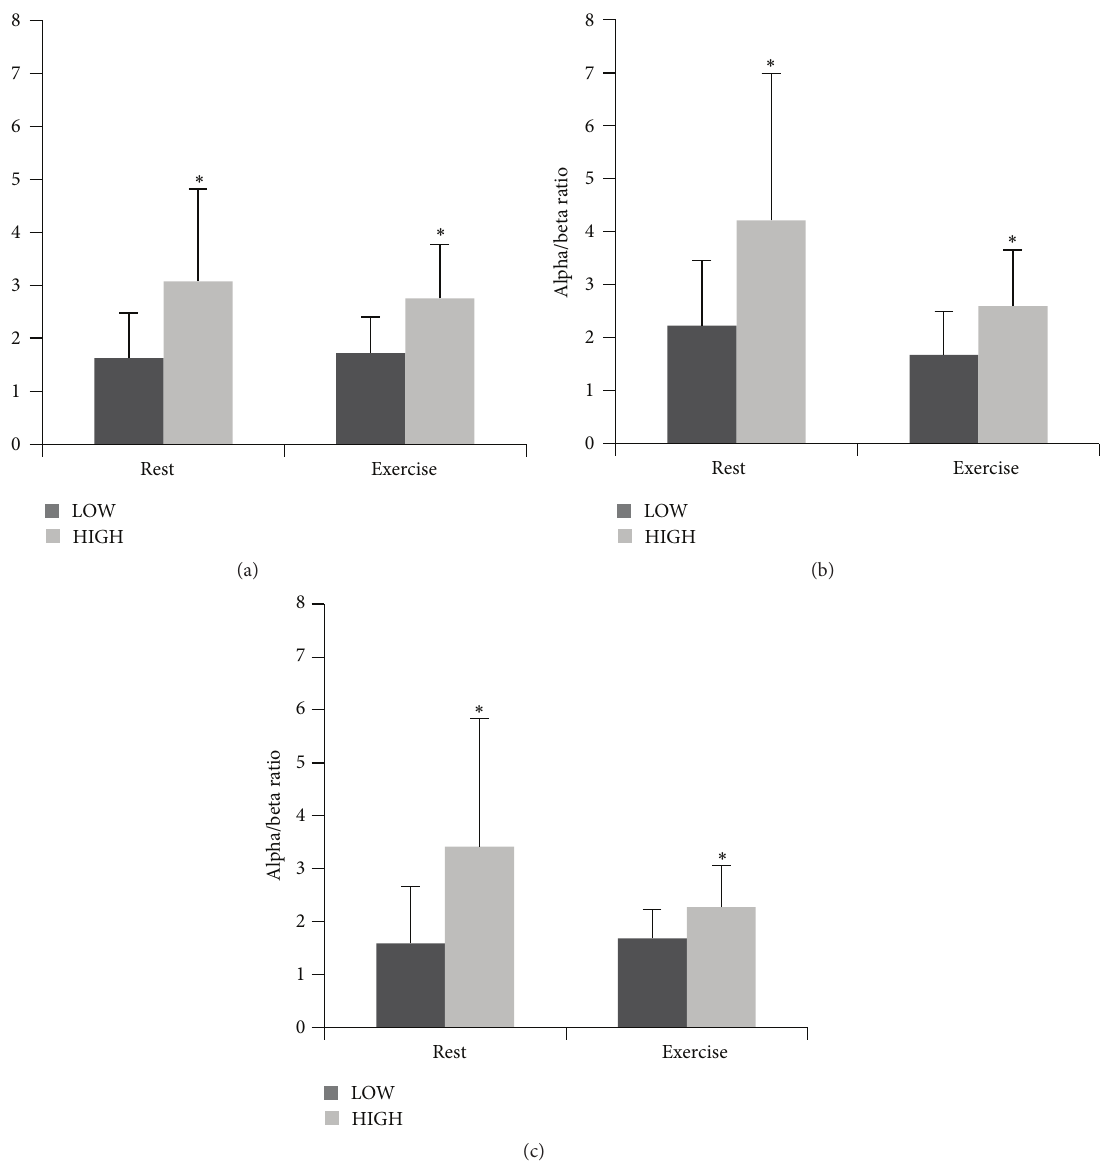
Figure 1: Alpha/beta ratio in HIGH and LOW at frontal (a), central (b), and parietal (c) electrode sites. ∗ 𝑝 ≤ 0.05 compared to LOW.